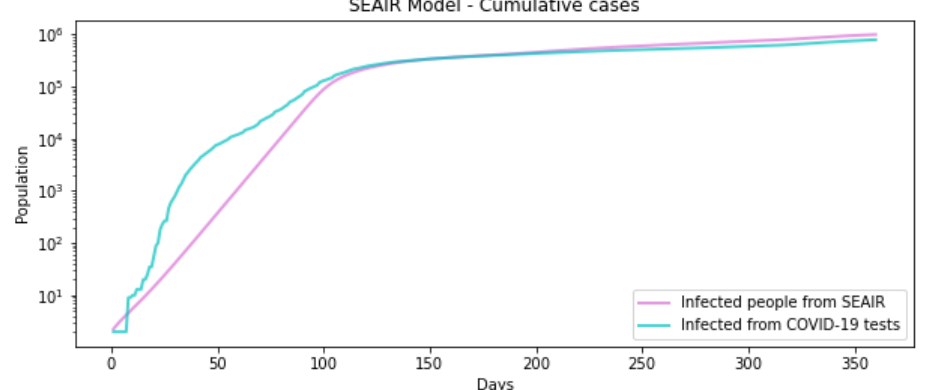
Figure 20. Comparison of cumulative infected people between SEAIR model and COVID-19 tests in Chile. First and second